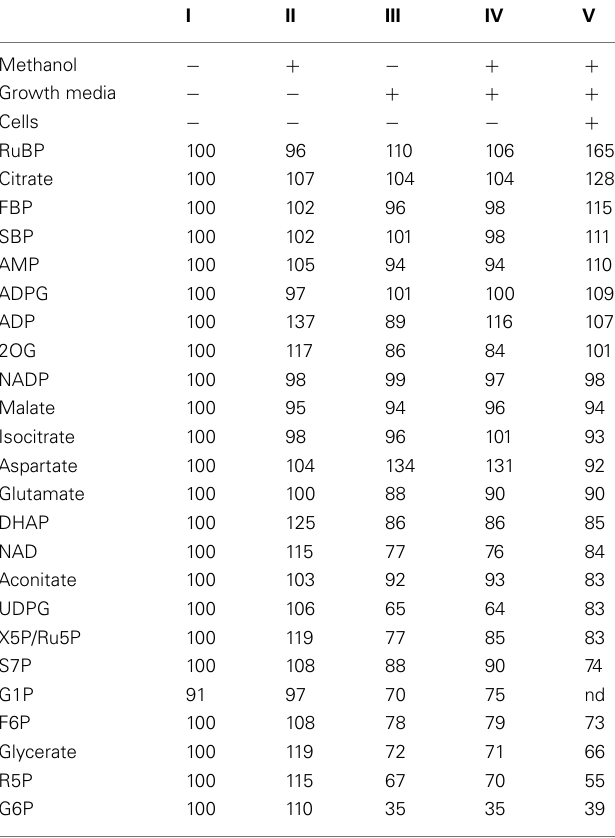
Table 1 | Ion suppression mainly caused by growth media. signal was suppressed by the media, but for many other metabo- lites including dihydroxyacetone-phosphate (DHAP),